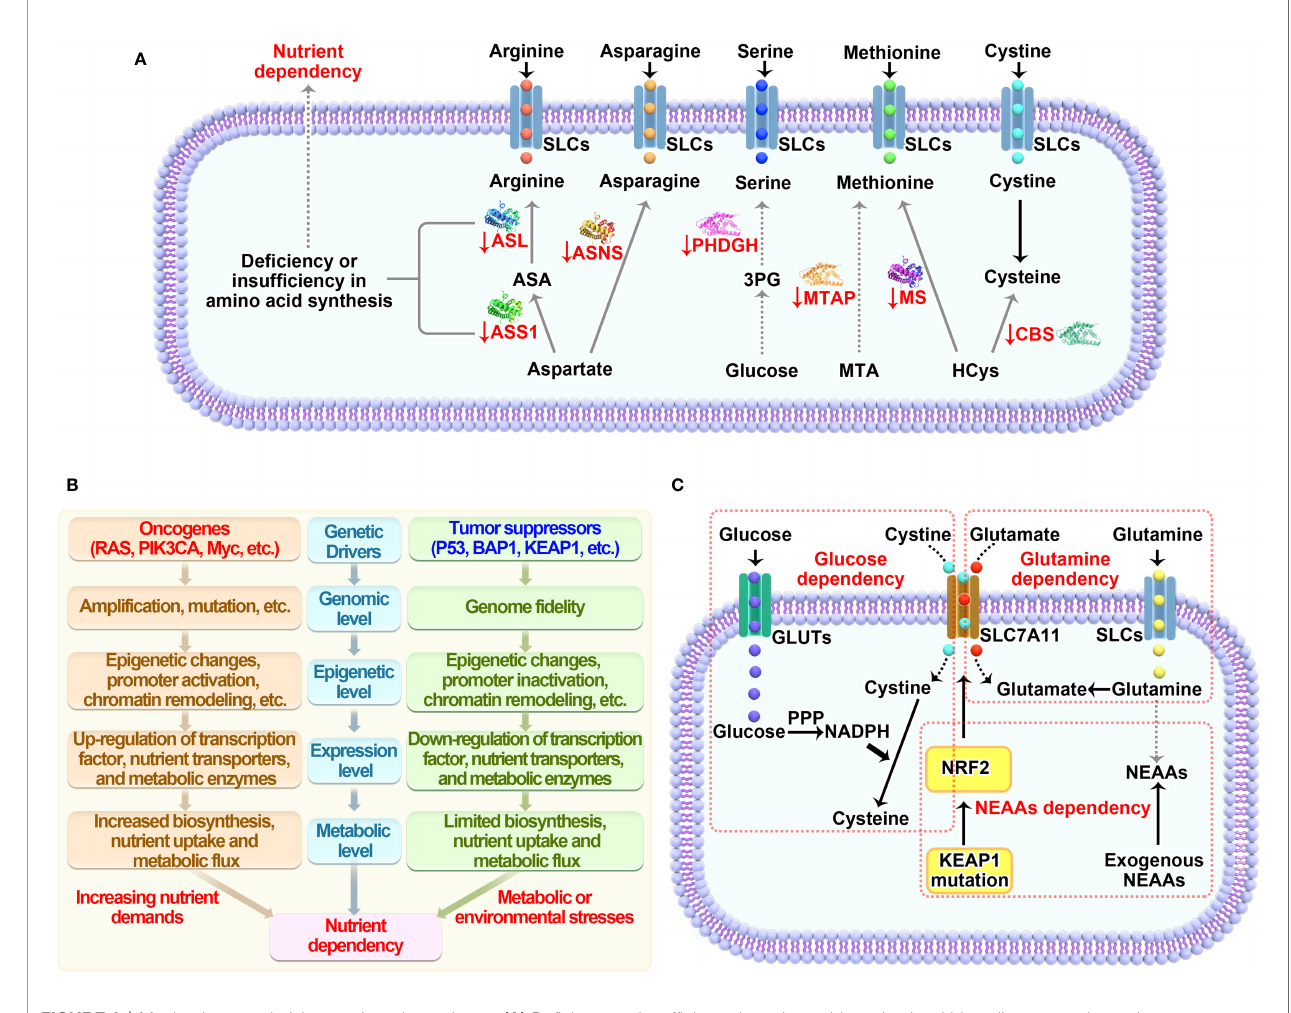
FIGURE 2 | Mechanisms underlying nutrient dependency. (A) De fi ciency or insuf fi ciency in amino acid synthesis within cells causes dependency on extracellular nutrients. (B) Genetic factors including oncogenes and tumor suppressors either directly regulate the expression of transporters and enzymes mediating nutrient metabolism or indirectly control the demands needed for cell growth, which imposing speci fi c dependencies on certain nutrients. (C) Nutrients involving crosstalk in their metabolic pathways are prone to be co-dependent on each other to maintain cellular homeostasis. SLCs, solute carrier- type transporters; GLUTs, glucose transporters; ASS1, argininosuccinate Synthase 1; ASL, argininosuccinate lyase; ASNS, asparagine synthetase; MTAP, methylthioadenosine phosphorylase; MS, methionine synthase; CBS, cystathionine beta-synthase; PPP, pentose phosphate pathway; HCys, homocysteine; MTA, S-methyl-5 ’ -thioadenosine; NADPH, reduced nicotinamide adenine dinucleotide phosphate; NEAAs, non-essential amino